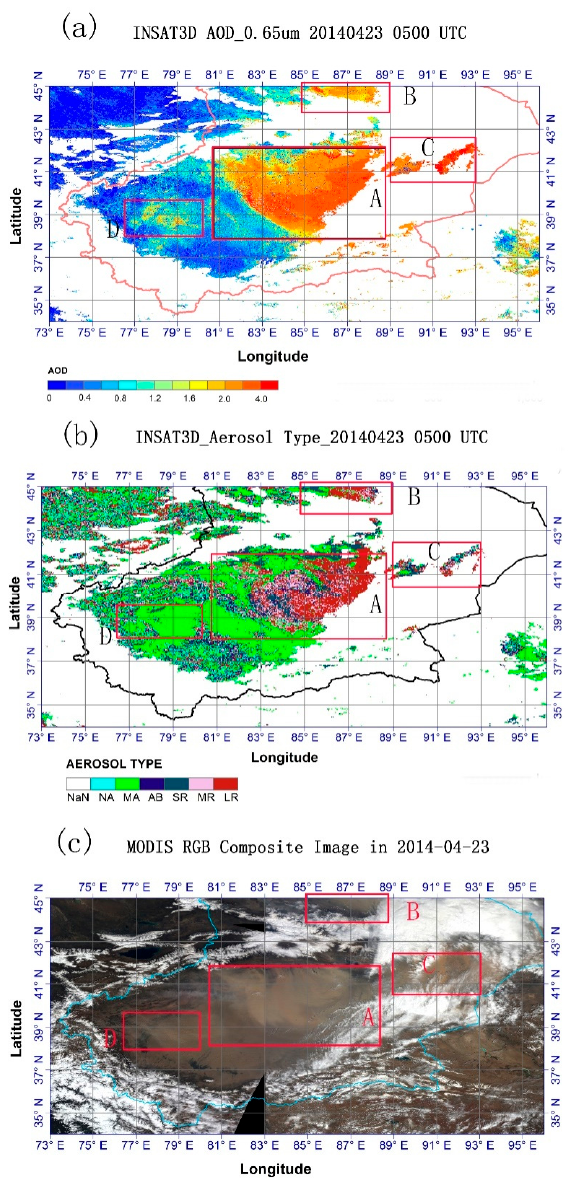
Figure 7. Comparison among: the retrieved INSAT-3D AOD ( a ); aerosol types ( b ); and MODIS RGB image ( c ) at the corresponding time (NA: NONABS, MA: MODABS, AB: ABSORB, SR: SMARAD, MR: MEDRAD, LR: LARRAD, NaN: Not a Number).